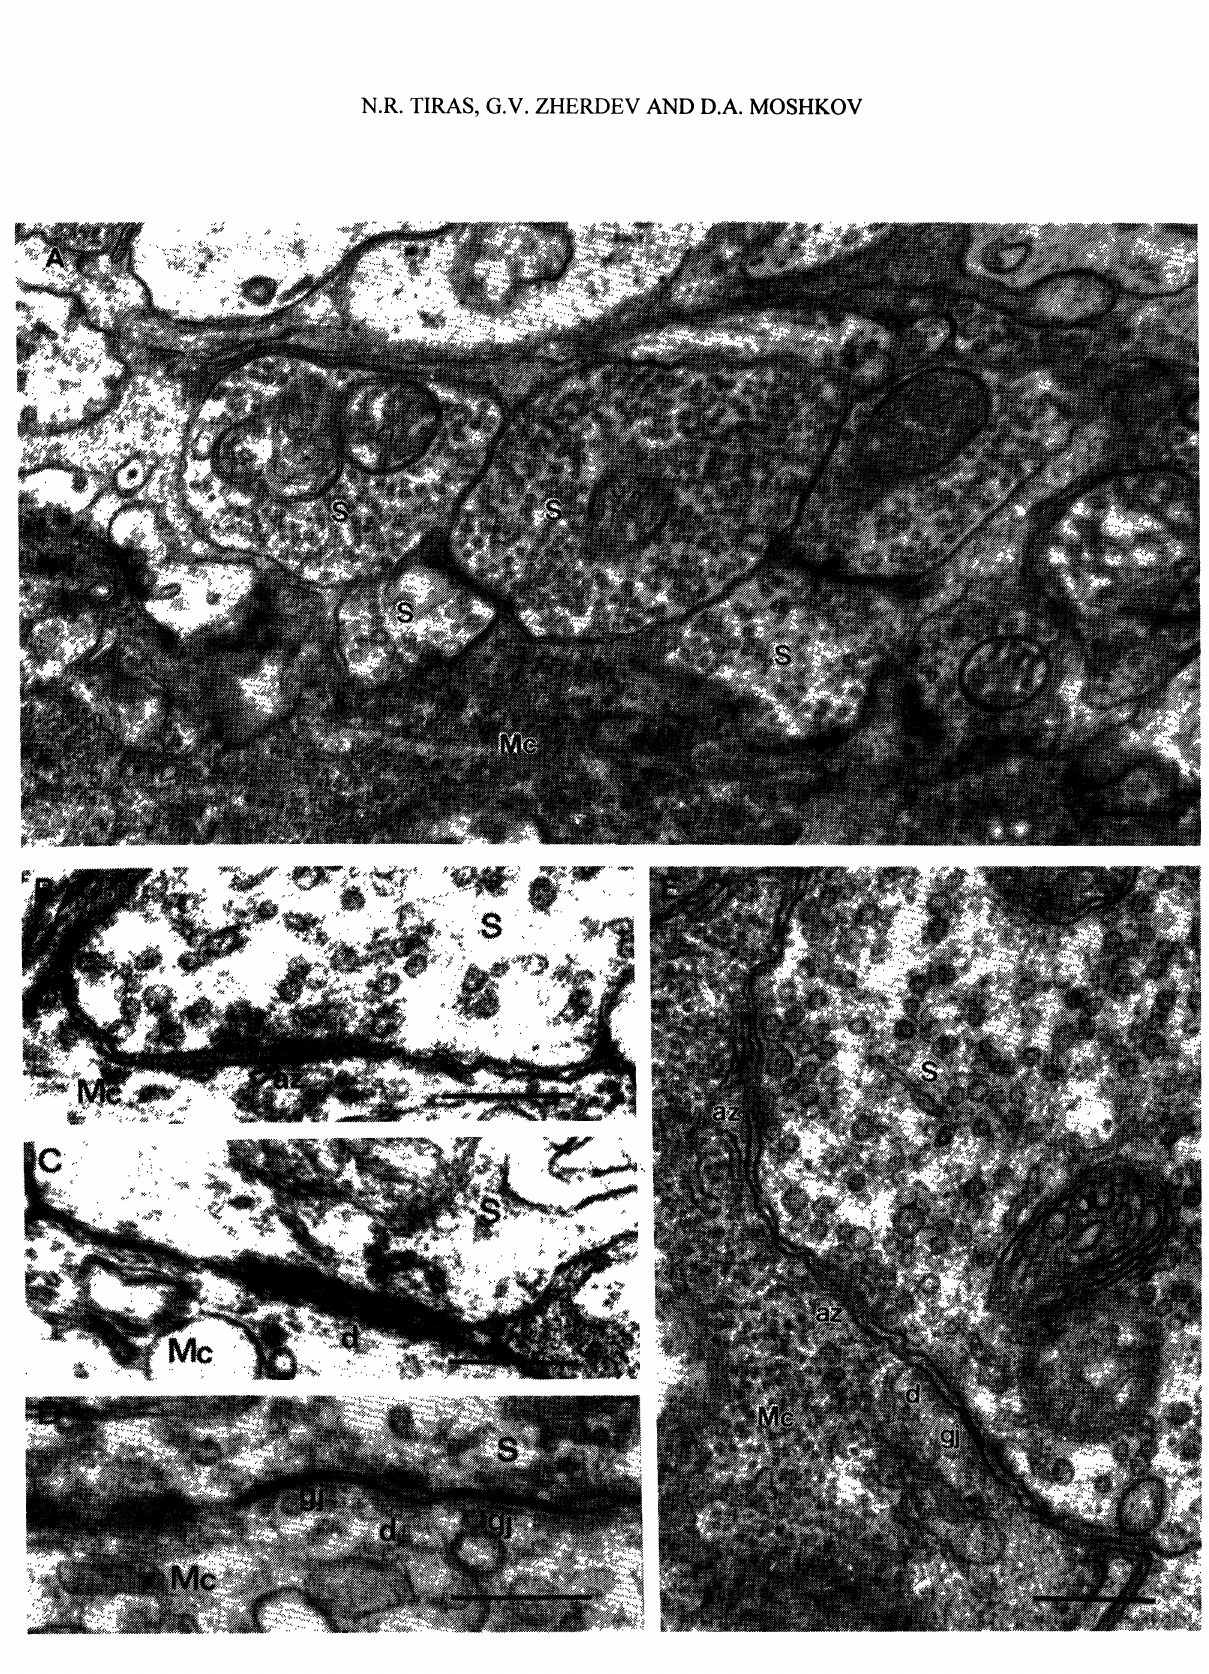
Fig. 1 Synaptic boutons (S) on M-cell soma (Mc). (a) Control fish; (b) (c) and (d): Specialized contacts -active zone (az), gap junction (g/), (d) desmosome-like structure in M-cells of fish from different groups; (e) Trained fish. No differences in the length and the number of active zones and of gap junctions were found in M-cells of control and ethanol exposed fish. The structure of synaptic endings in trained fish did not practically differ from control. Scale bar 0.25 la